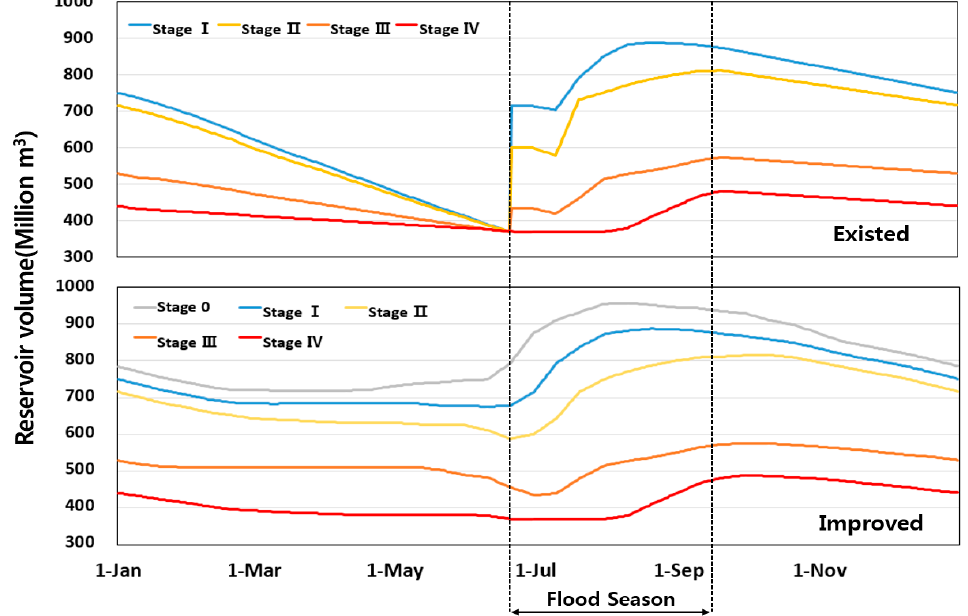
Figure 1. Comparison of standard daily water volume lines by five drought response stages: Stage 0 (no drought; gray); Stage I (attention; blue); Stage II (caution; yellow); Stage III (alert; orange); Stage IV (serious; red). Table 2. Description of water supply conditions by each drought response